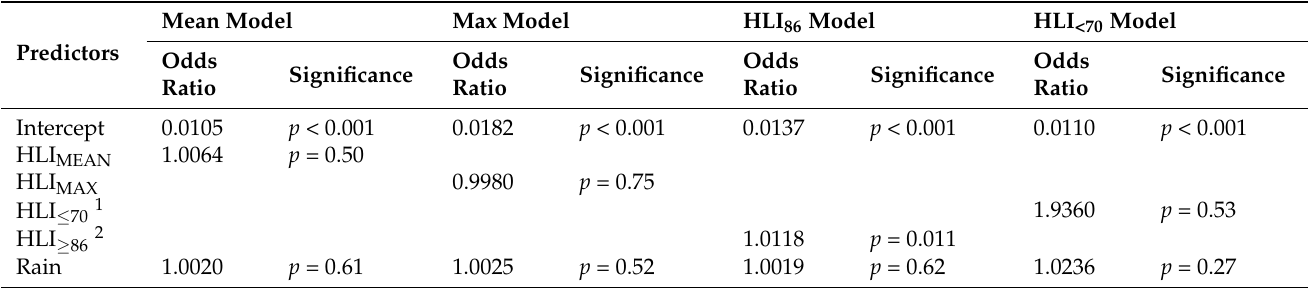
Table 10. The odds ratios for the effect of heat-load index (HLI) mean, max, min, HLI <70 1 , and HLI 86 2 plus rain (mm) on the incidence of pH